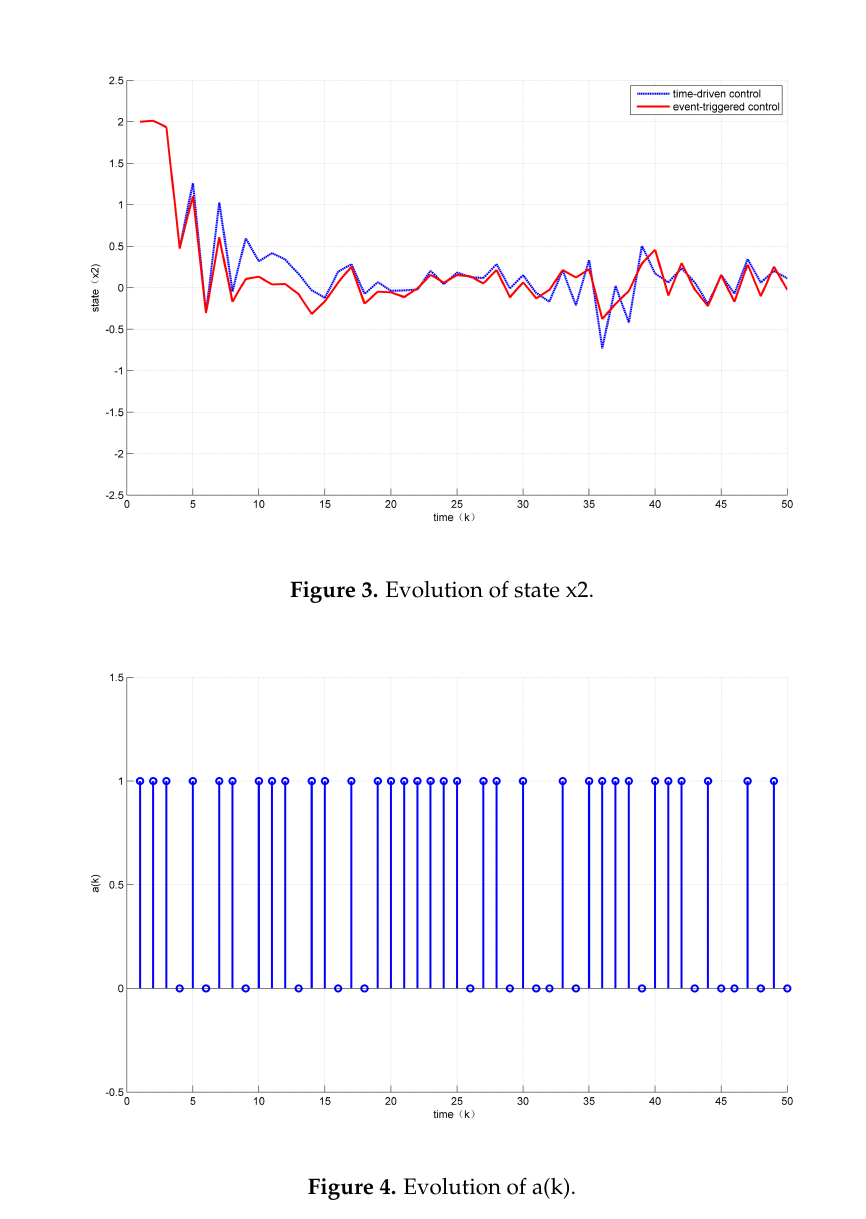
Figure 4. Evolution of a(k).